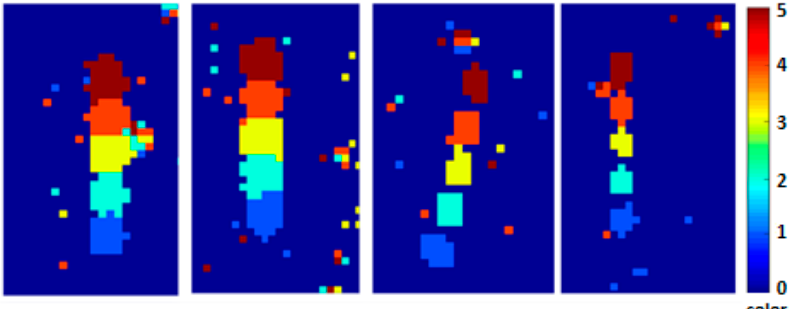
Figure 7. Motion targets in time information frames. (Five frame images maximum projection).